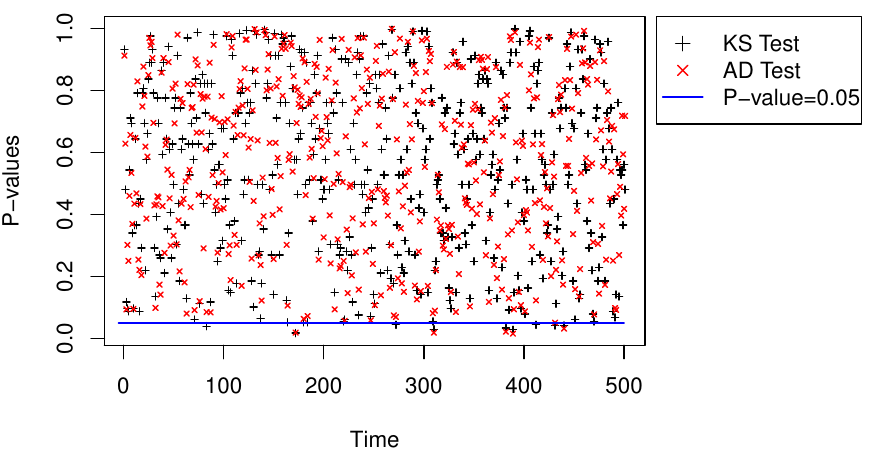
Figure 7. P-values of the KS and the AD statistics for the S&P 500 index.